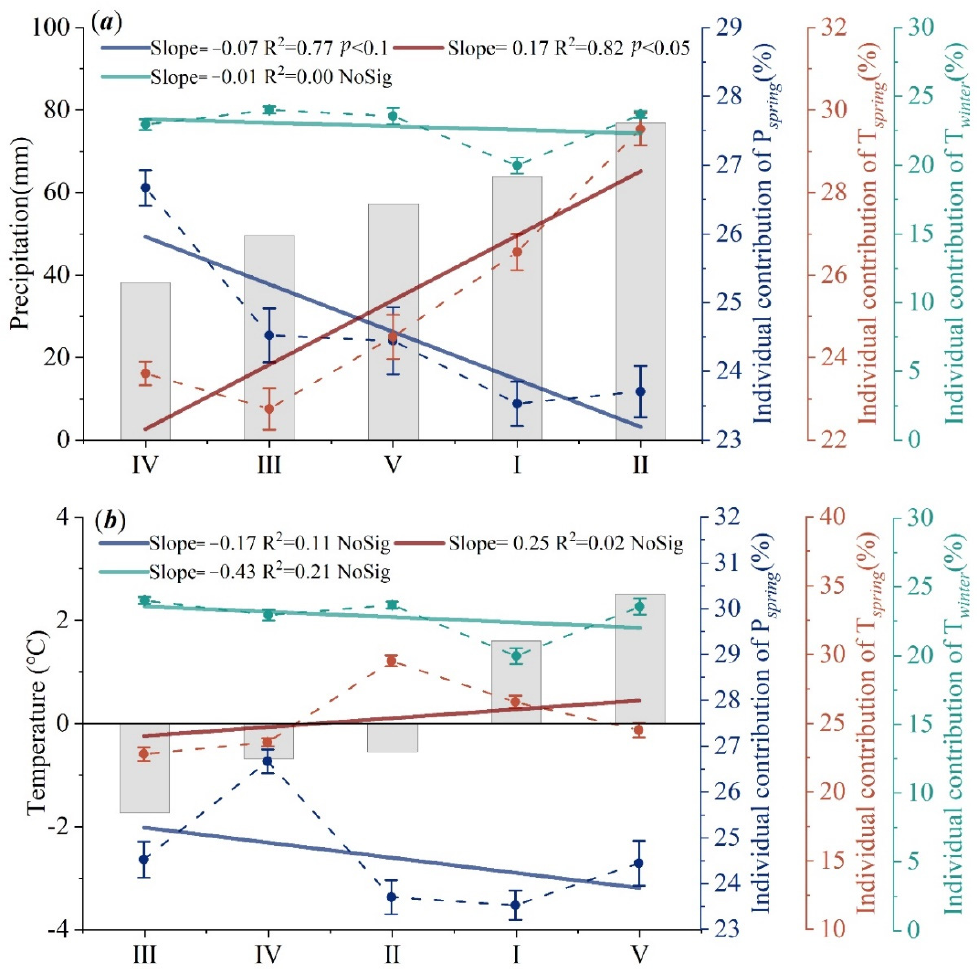
Figure 6. Variations in individual contribution of each climate factor for grassland spring phenology to long-term average cumulative precipitation ( a ) and mean temperature ( b ) in spring in different ecoregions across Tibetan Plateau. Bars indicate mean long-term average precipitation or temperature in spring for each ecoregion. Point and dashed curves represent averaged value of pixels with significant individual contribution at p < 0.05 level for each ecoregion listed in right y -axis labels. Solid line represents linear regression of individual contribution of each climate factor to long-term average precipitation or temperature. p value denotes significance. NoSig indicates that slope is not significant at p ≥ 0.05 level. I, II, III, IV, and V indicate different ecoregions following Figure 1.